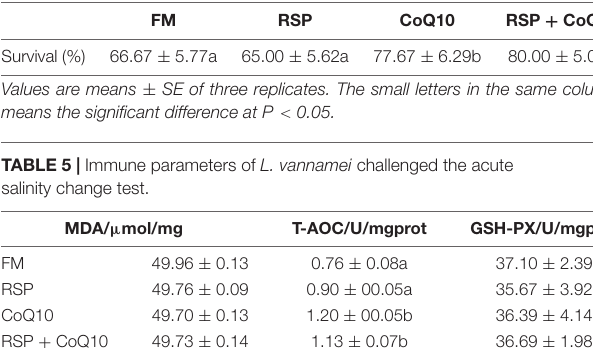
TABLE 4 | Survival rates after the acute salinity change test.